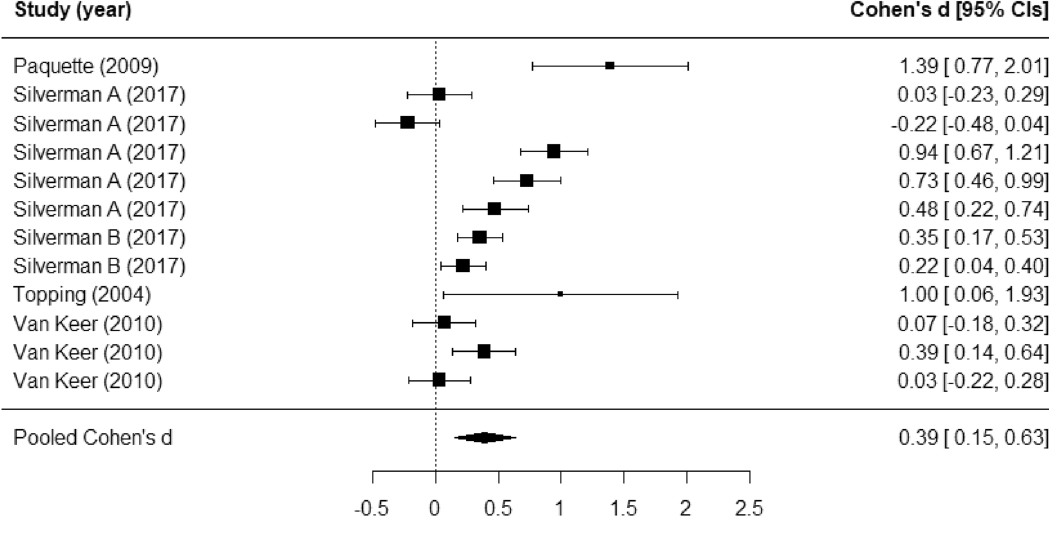
Figure 2. Forest plot for literacy